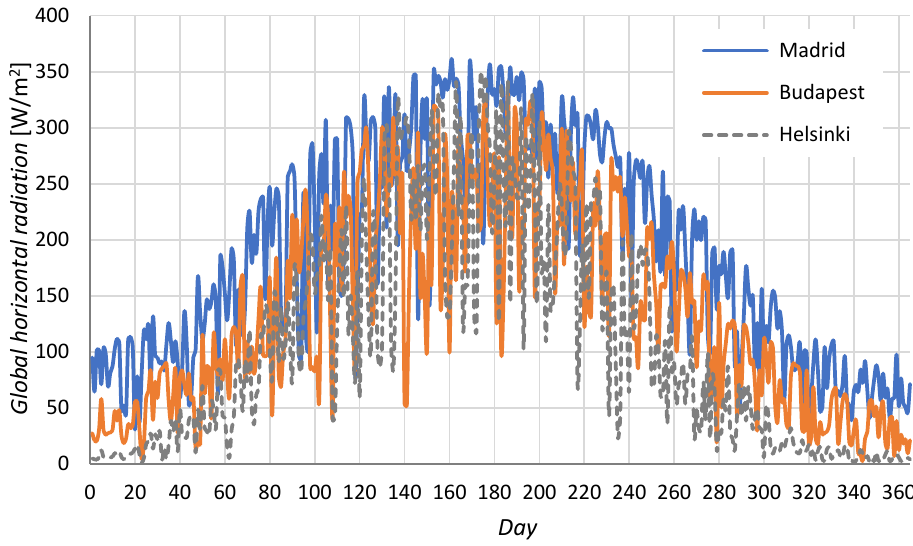
Figure 6. Average daily global solar radiation incident on a horizontal plane.